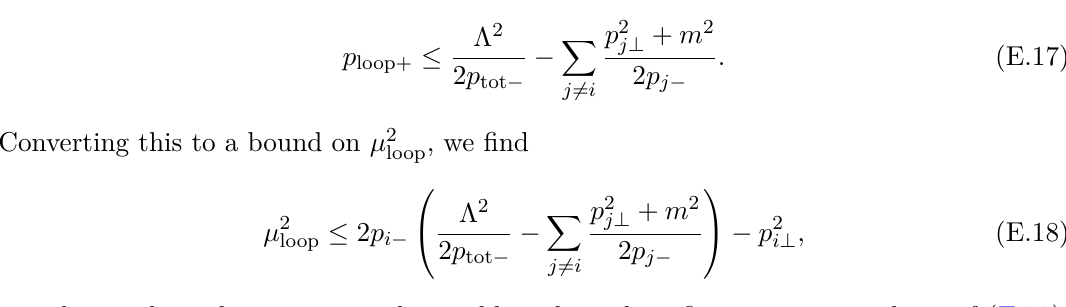
, the effective cutoff only reaches 1 √ tot |→∞